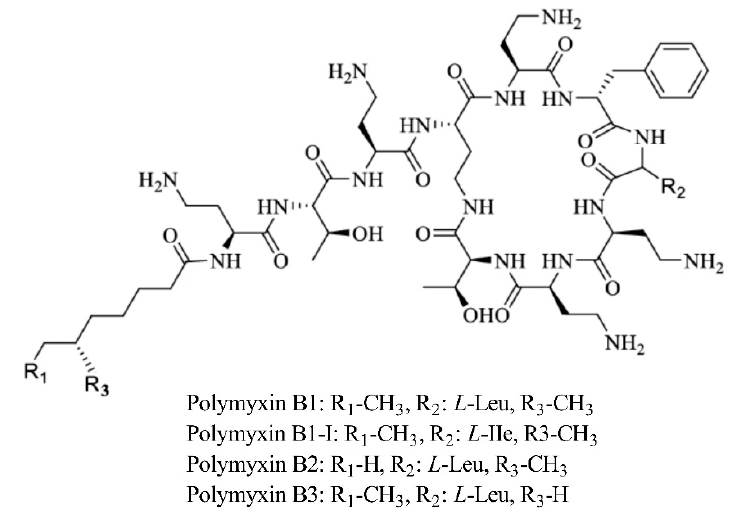
Figure 6. The chemical structure of PMB.